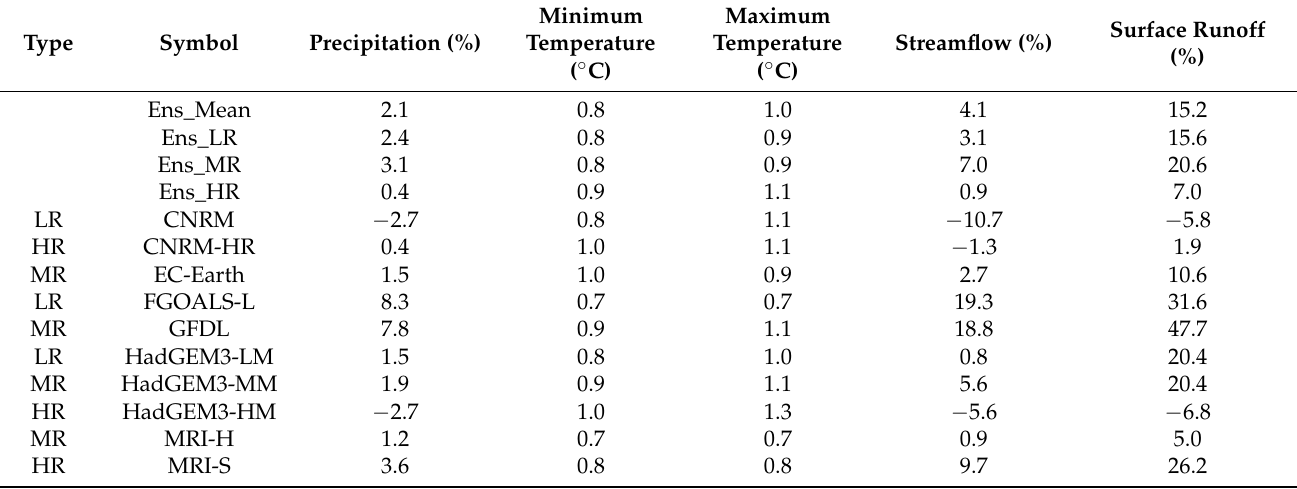
Table 4. Changes in annual total precipitation, annual mean daily minimum temperature and maximum temperature, streamflow at Rantau Panjang station and surface runoff under CMIP6 HighResMIP projections over the Johor River Basin between 2021 and 2050 and 1985 and 2014.